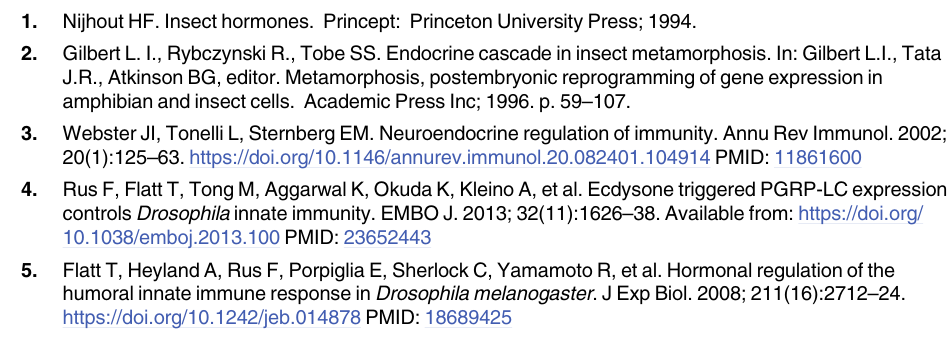
S11 Table. 5’-3’ sequences of primers used for qPCR. S12 Table. 5’-3’ sequences of primers used for tissue specific CRISPR. Guide RNA (gRNA) sequences are represented in capital letters. S1 Data. Numerical data for every dataset and figure in the manuscript. For qPCRs, each number on the sample name represents a biological replicate. The expression level of each gene in all of these was measured